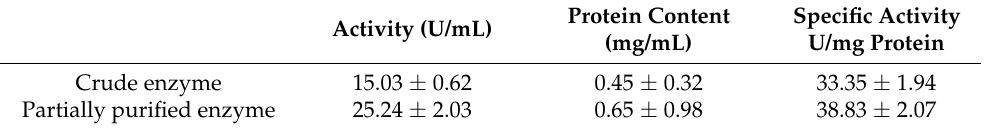
Table 1. Activity, protein content, and lipases specific activity of crude and partially purified enzyme. Protein Content Specific Activity Activity (U/mL) (mg/mL) U/mg Protein Crude